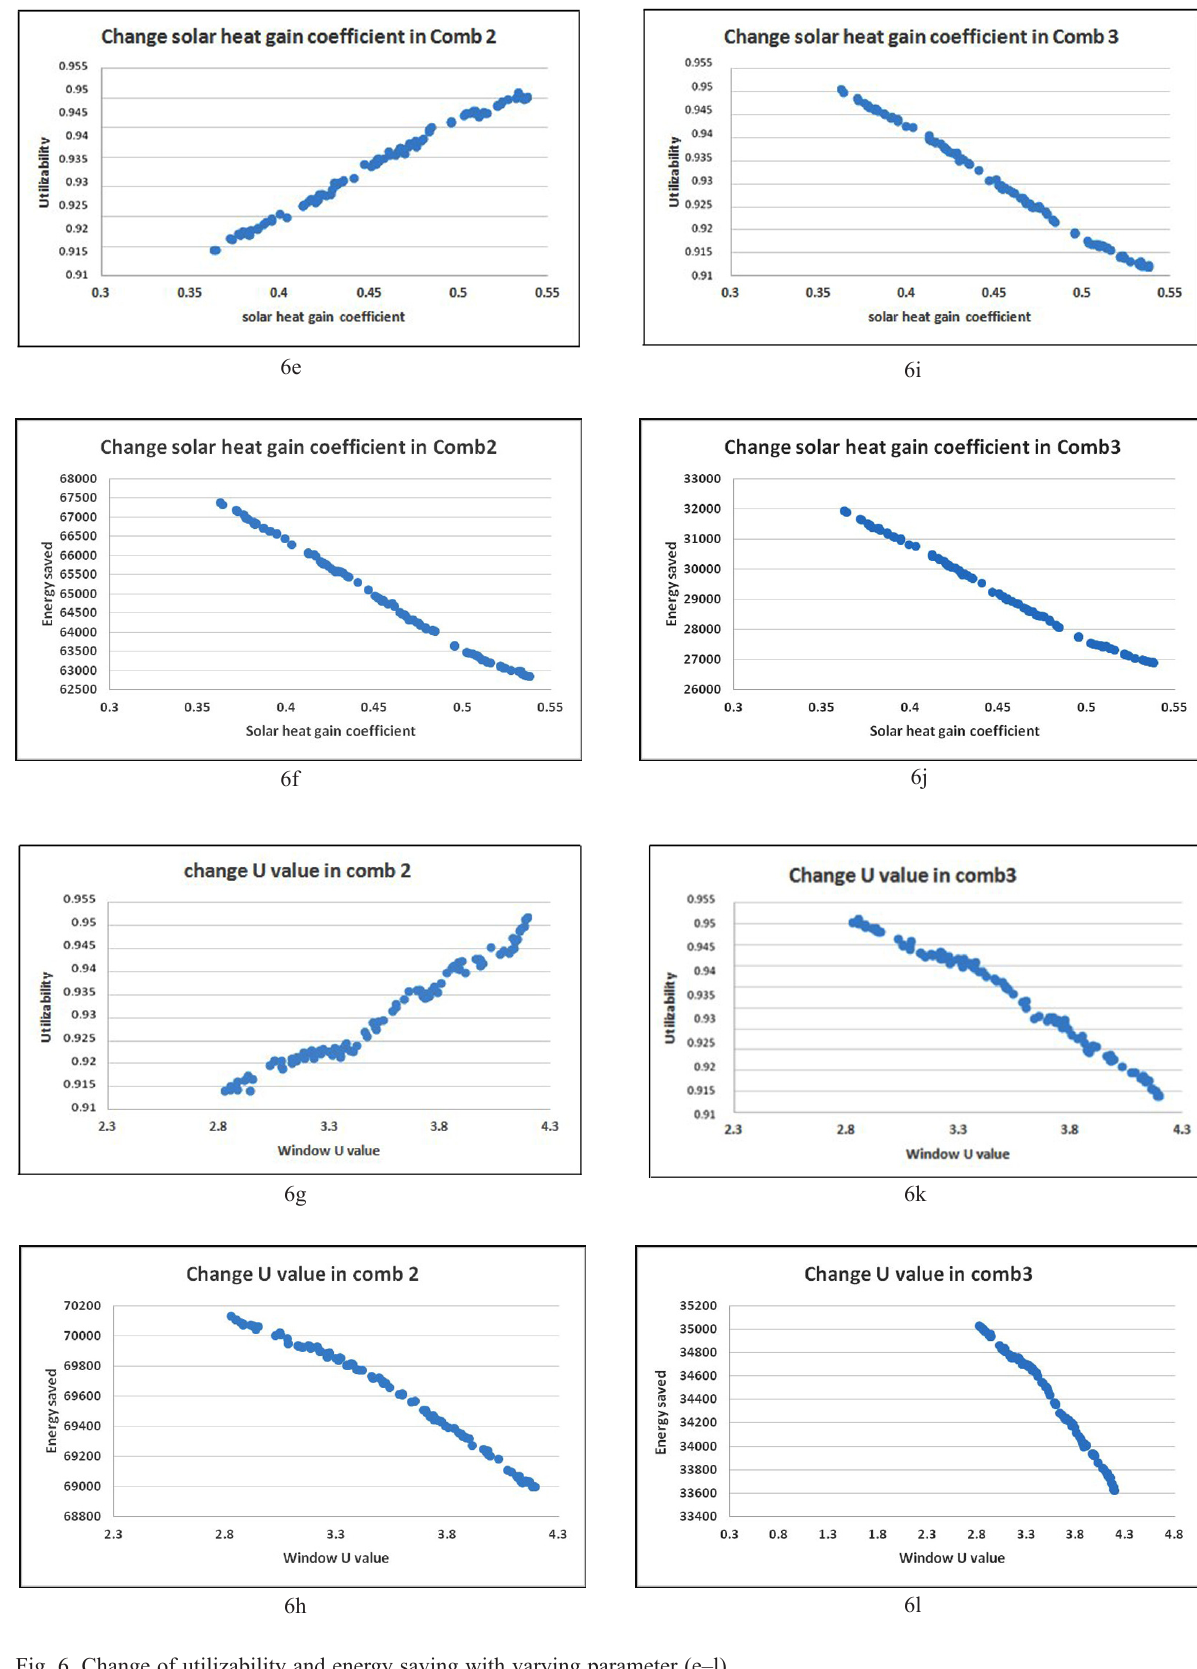
Fig. 6. Change of utilizability and energy saving with varying parameter